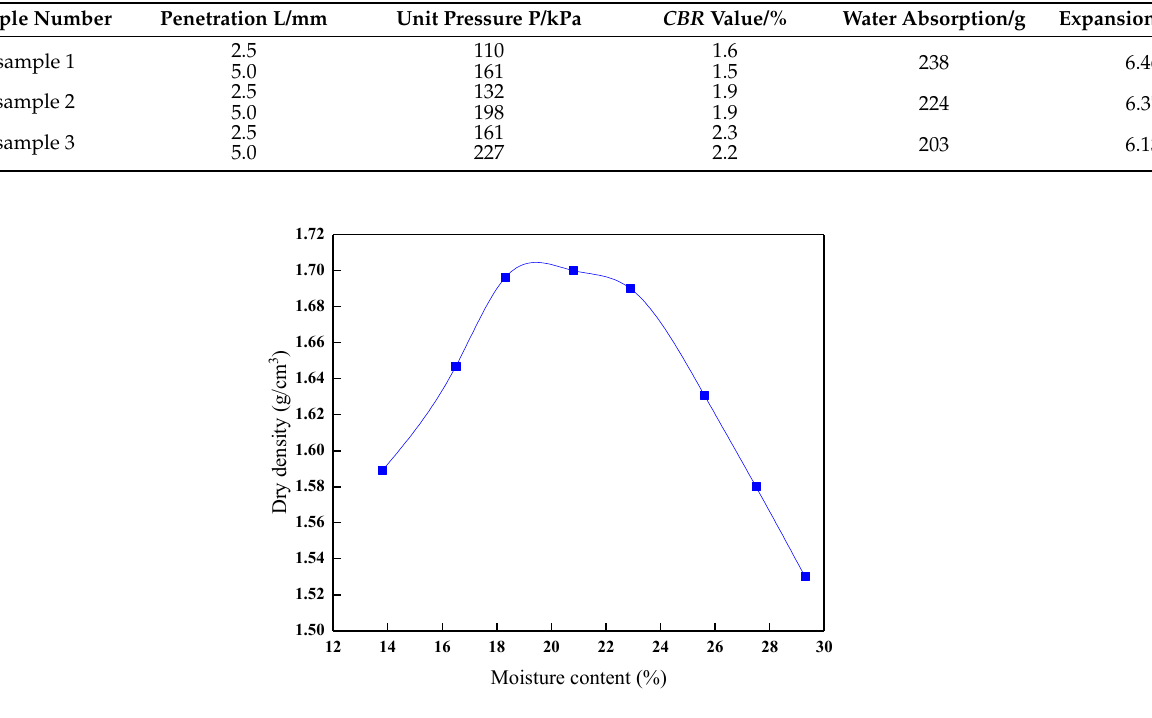
Figure 5. Compaction test curve.